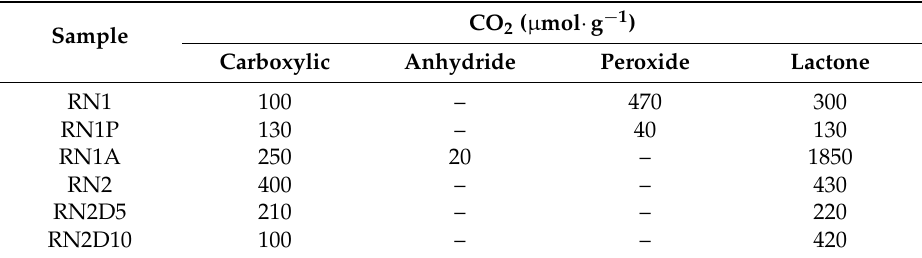
Table 5. Oxygen surface complexes distribution from CO 2 TPD